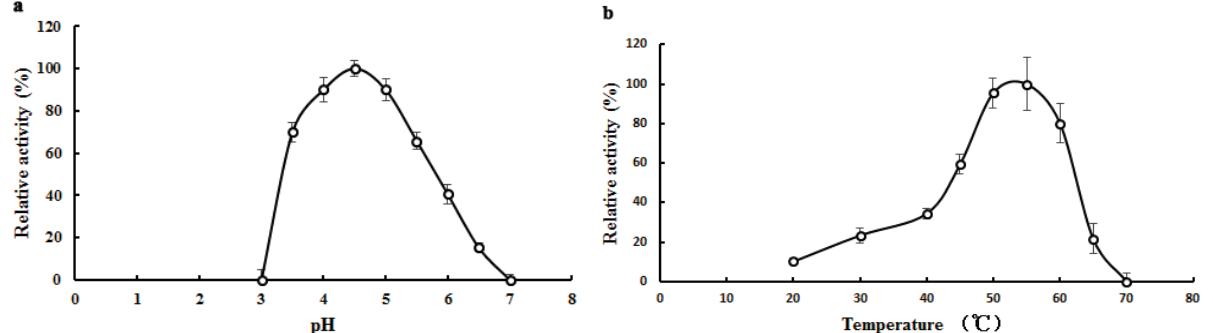
Figure 2. Effects of pH and temperature on the activity of Tricholoma matsutake α -galactosidase. ( a ) Effect of pH on TMG. Buffer: 0.1 M Na 2 HPO 4 -citric acid buffers. Results represent mean ± SD ( n = 3); ( b ) Effect of temperature on TMG. Results represent mean ± SD ( n =